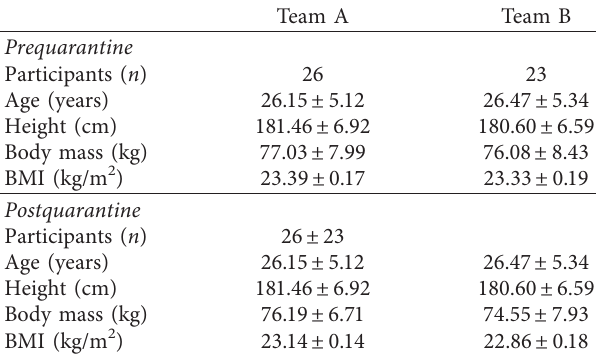
Table 1: Demographic and anthropometric characteristics of the sample before and after the quarantine period (means ± standard